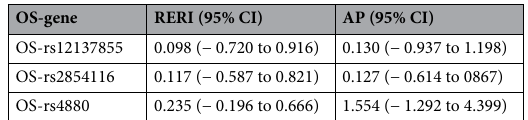
Table 7. Analysis of the additive interaction of OS-gene.